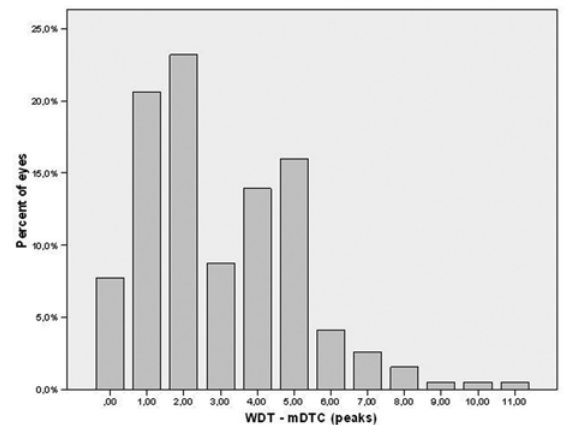
Figure 1 - Distribution frequency of the differences between IOP peaks during the WDT and mDTC